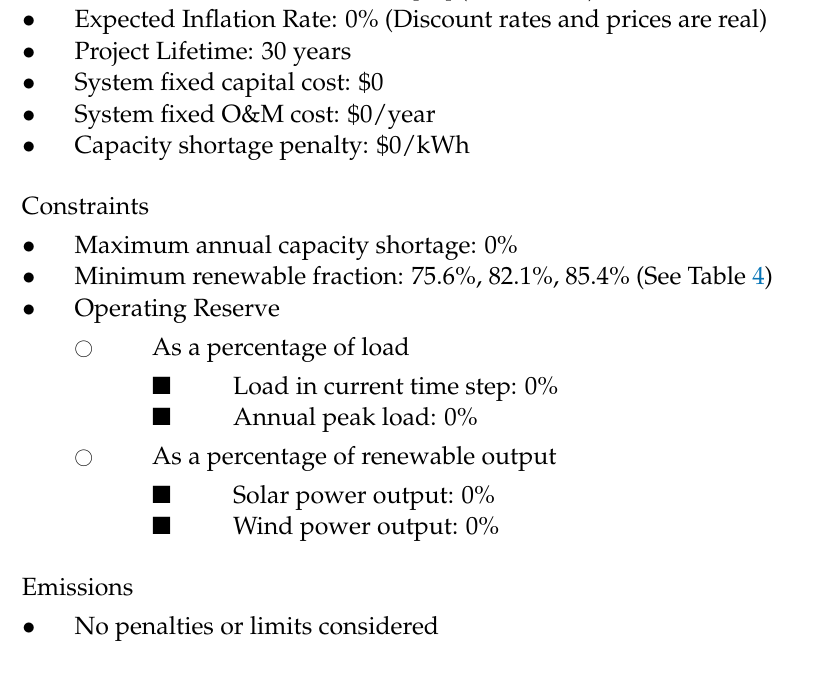
Figure A3. Monthly air temperature distributions for each case study.